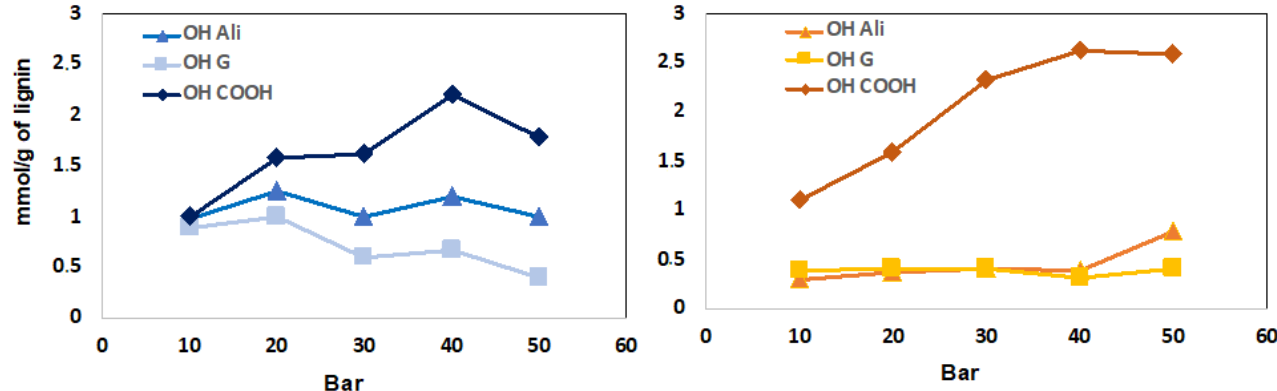
Figure 4. Evolution of carboxylic acid (COOH), guaiacol (G) and aliphatic alcohol (Ali) units according to the air pressure used for LNP ( left ) and LNW ( right ).